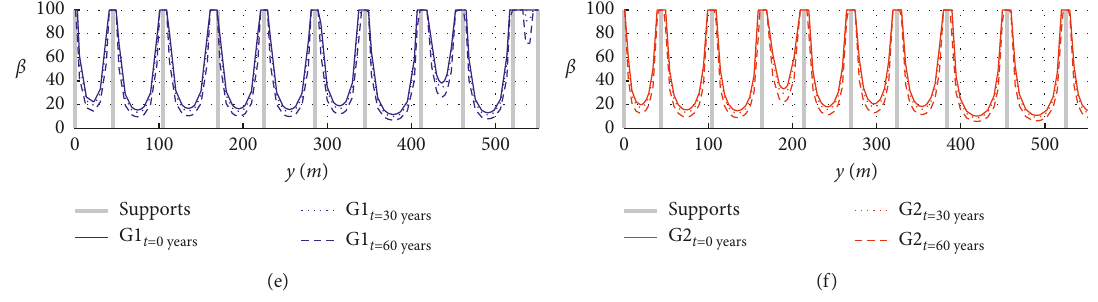
Figure 13: Reliability index for the girder for different lifetimes.